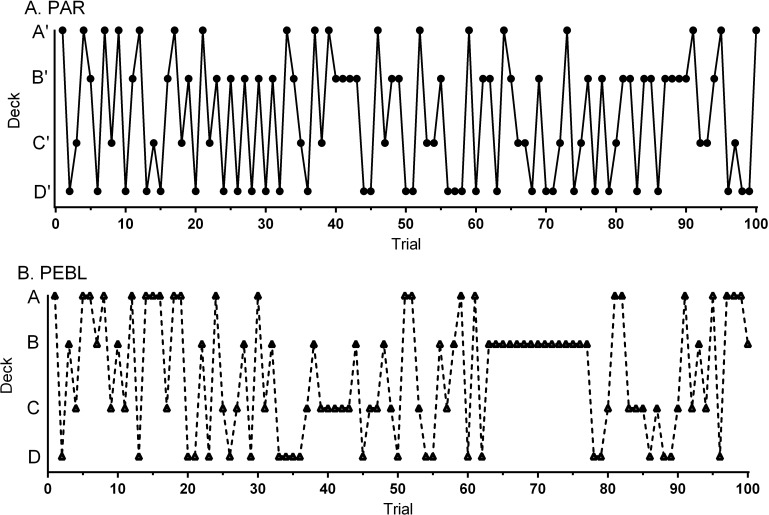
Deck selections over one-hundred trials for the participant (a 34 year-old, Native American female) with the median NET1–5 (0) on the Psychological Assessment Resources (PAR) Iowa Gambling Task (A). Deck selections for the participant (a 18 year-old Native American male) with the median NET1–5 (−2) on the Psychology Experiment Building Language (PEBL) Iowa Gambling Task (B).